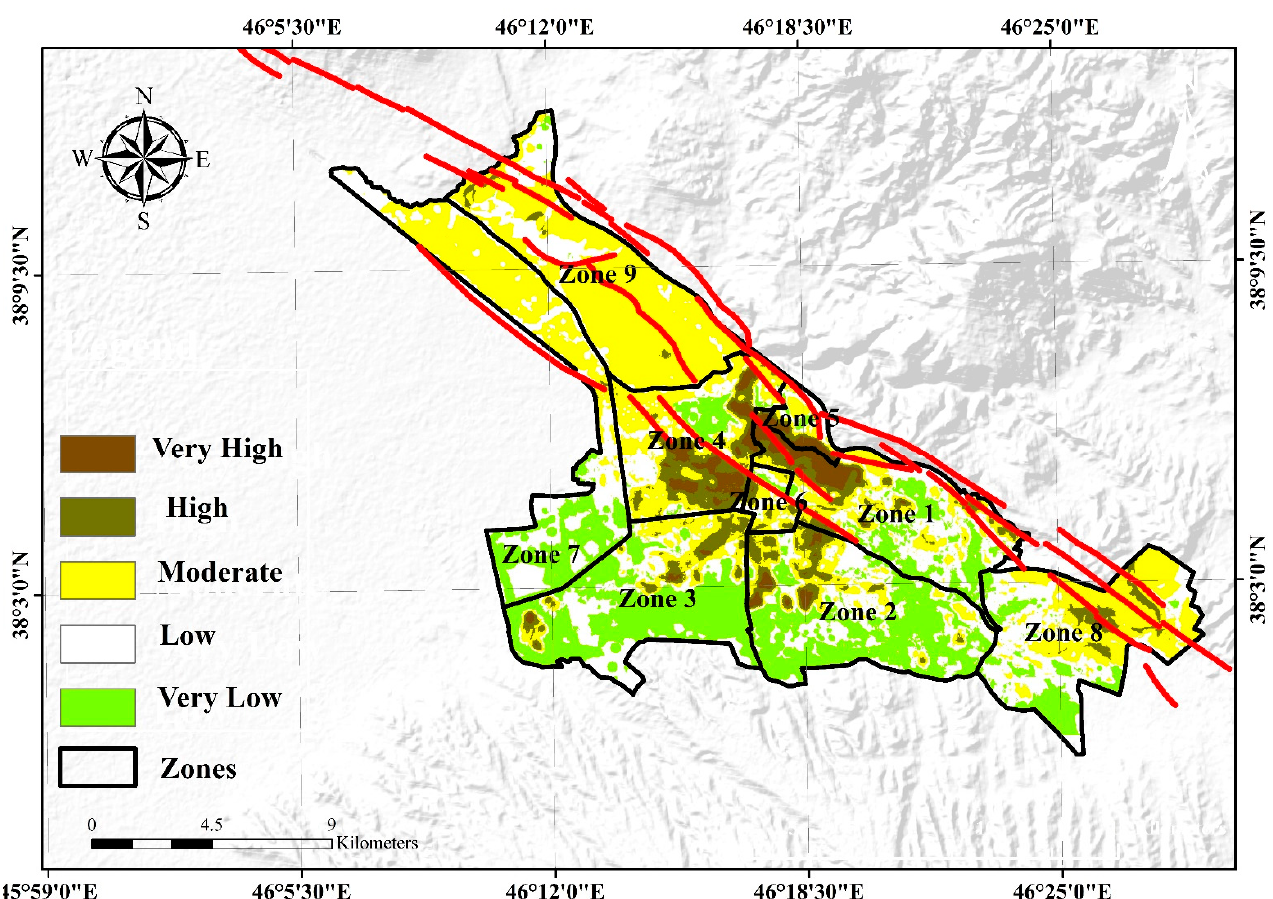
Figure 3. Earthquake vulnerability in Tabriz, Iran, by municipality, provided by MLP. As can be seen in Table 8, the MLP data show that 16.14% and 14.26% and of Zone five is classified as being very highly and highly vulnerable, respectively. Zone four encompasses 1.08% and 25.57% of land that is very highly and high vulnerable, respectively. Zone one which is also of concern given it has 5.74% and 9.80% of land classed as very highly and highly vulnerable, respectively (Table 8). The other zones are of less concern. However, identifying the size and area of the land that is vulnerable is not enough to determine the adverse effects of an earthquake. As shown above for the SOM, population density and residential building density also need to be accounted for when forecasting impacts. This enabled us to better understand Population Vulnerability and Residential Building Vulnerability in various zones of Tabriz to better evaluate how to reduce impacts of an earthquake by finding the intersect between seismically vulnerable land zones that are also characterized by high population and residential building density. Tables 9 and 10 show the relative vulnerability of the different municipality zones in Tabriz as obtained by overlaying the Earthquake Vulnerability Map (EVM) with population and residential building data. The potentially most vulnerable areas are clustered in Zones five, four and one, respectively, which are located along the NTF. Residents in these zones are known to earn lower than average income and reside in small housing properties causing an overall population and building density. Conversely, the least vulnerable zones were Zone seven, Zone three and Zone